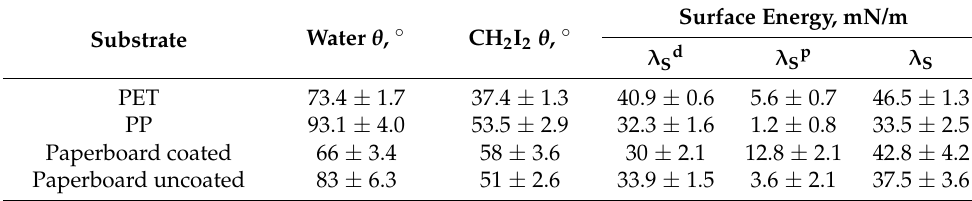
Table 2. Surface free energy parameters of the used materials.